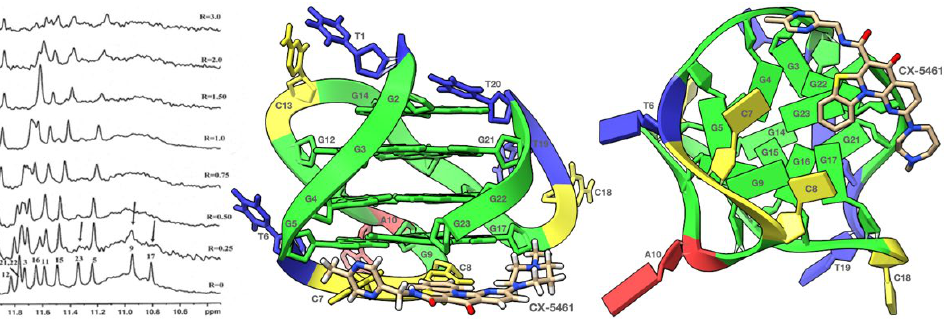
Figure 6 . Imino proton region of 1D NMR titration spectra of TP3-T6 with CX- 5461 at 25 °C at different R = (drug)/(DNA) ratios (Left). The complex between TP3-T6 and CX-5461 was obtained by molecular docking and the side (Center) and 3 ′ -end (Right) views were created by using the ChimeraX software., nucleotides are shown in sticks to reveal atoms and bonds, the nucleotides in the side (Center) view are rendered in stick while in the 3 ’ -end (Right) view they are shown as slabs and filled sugars. Adenine residues are colored in red, Cytosine in yellow, Guanine in green and Thymine in blue. In both views the ligand is represented as sticks and colored according to the atoms.